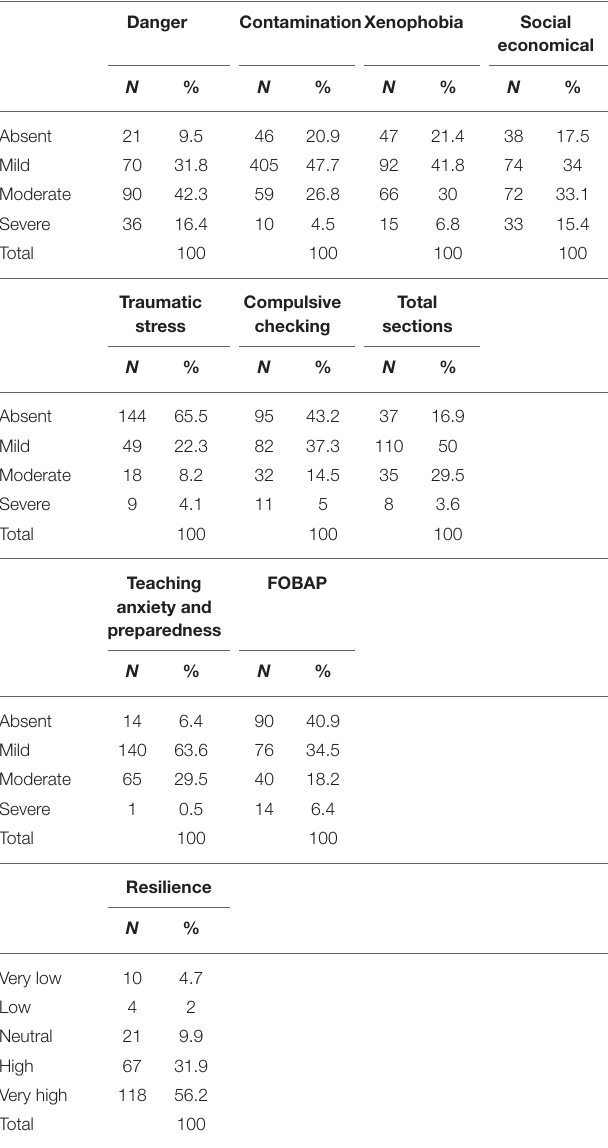
TABLE 3 | COVID-related stress frequency for the ACSS, teaching anxiety and preparedness, and resilience for academic professionals.